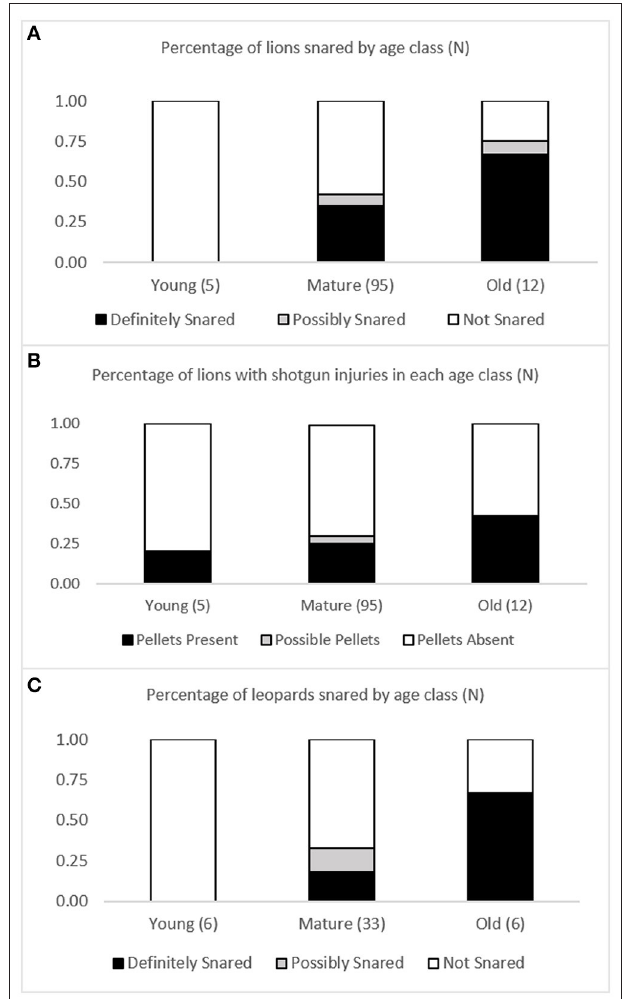
FIGURE 5 | Incidence of non-lethal anthropogenic injuries in each age class. (A) Percentage of lions snared in each age class, (B) percentage of lions with shotgun pellets in each age class, (C) percentage of leopards snared in each age